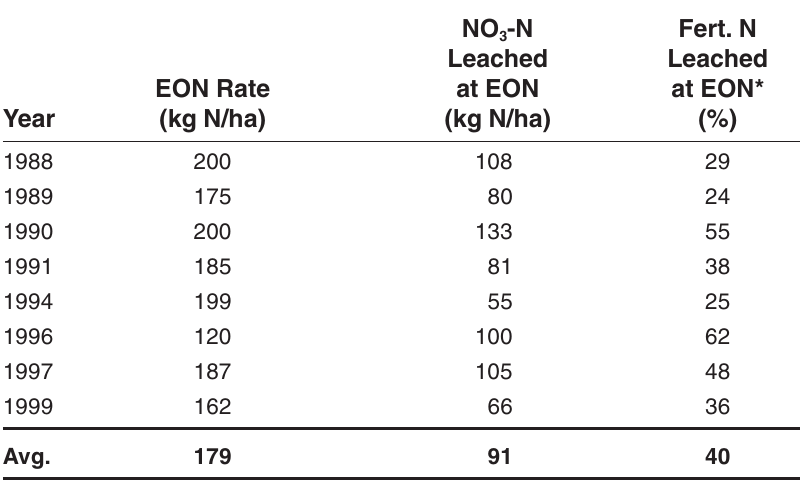
Estimated Mass of NO -N Leached from Non-Manured 3 Corn at the Economic Optimum N Rate